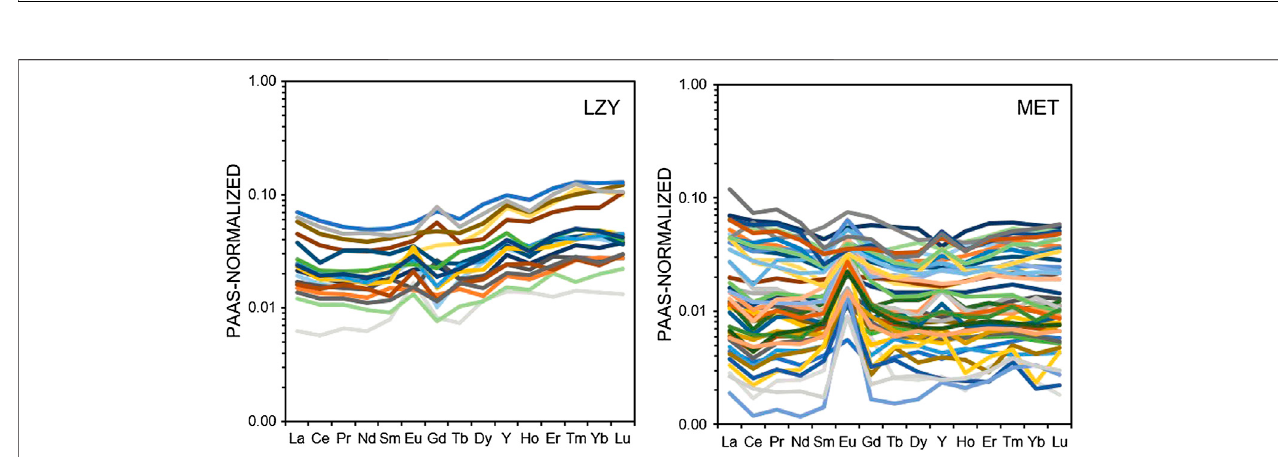
FIGURE 8 | PAAS-normalized REE patterns of the MET and LZY sections, showing the LREE depletion and the positive Eu anomaly.